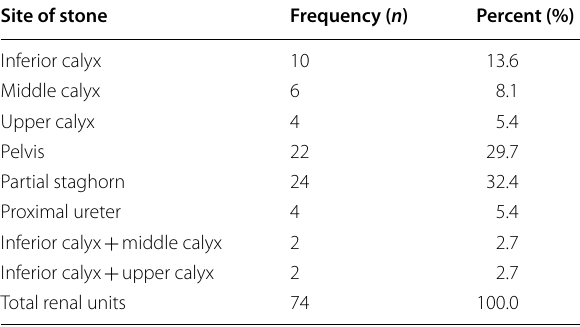
Table 2 Site of renal calculi in Patients Site of stone